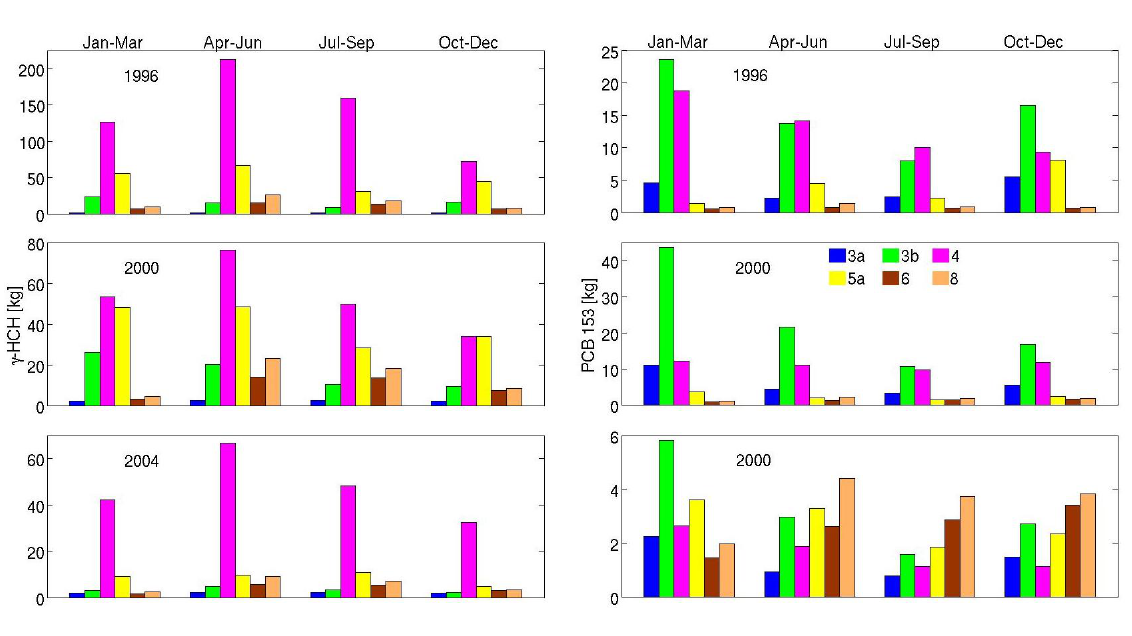
Figure 15. Bar charts of quarterly (3 month) POP river input into ICES boxes (kg) of γ-HCH (left) and PCB 153 (right) for 1996, 2000 and 2004. All rivers entering any particular box are